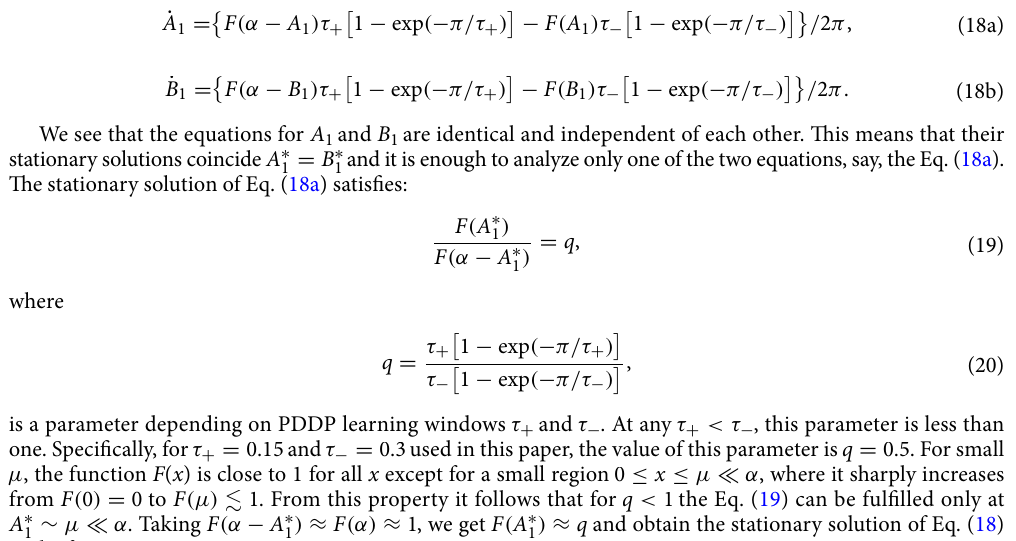
Figure 2. Sharpness parameter µ effect on synaptic weigths. ( a ) Graphical solution of the equation K f 1 ( K ) f 2 ( K ) at different values of the parameter µ of the power boundary function (4). The stationary = + value of the variable K is defined by the intersection of the function f 1 ( K ) The values of the parameters are the same as in Fig. 1. ( b , c ) Stationary solutions of Eq. (15) corresponding to unsynchronized state of the system in dependence of the sharpness parameter µ for ( b ) power (4) and ( c ) sigmoid (5) boundary functions. The dashed curves in ( b , c ) show the analytical predictions (22) and (23), respectively, which are valid for small values of the parameter µ